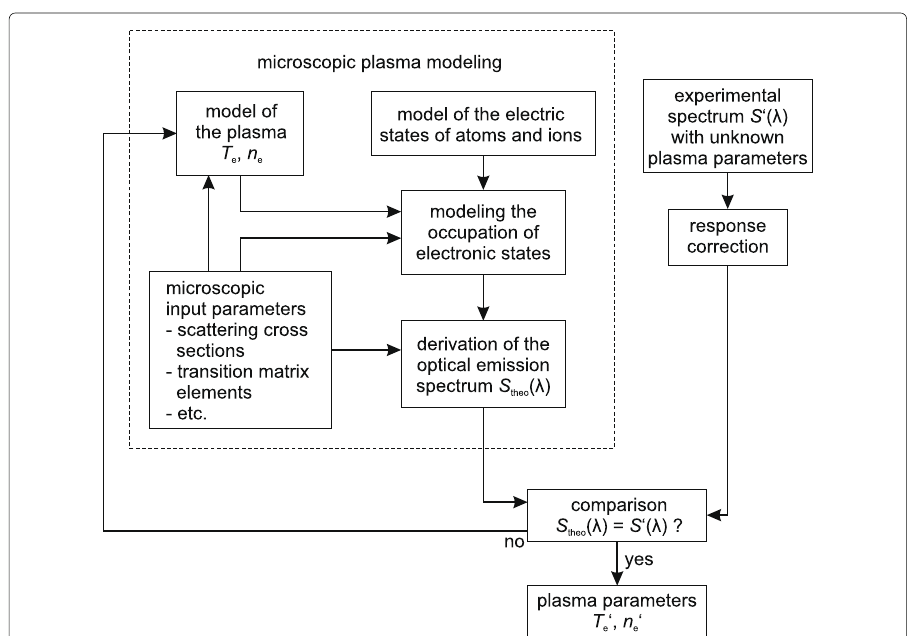
Fig. 1 Schematic description of the work flow necessary to extract plasma parameters from an experimental optical emission spectrum S (cid:2) (λ) by comparison with microscopic theory. The theoretical model contains a microscopic description of the plasma as well as of the electronic states of its ions and atoms. The occupation of these states needs to be modeled based on the microscopic processes inside the plasma. The intensities of the optical transitions need to be calculated based on the occupation of the electronic states and the transition matrix elements in order to obtain a theoretical spectrum S theo (λ) , which can then be compared to the response-corrected experimental spectrum to obtain the plasma parameters